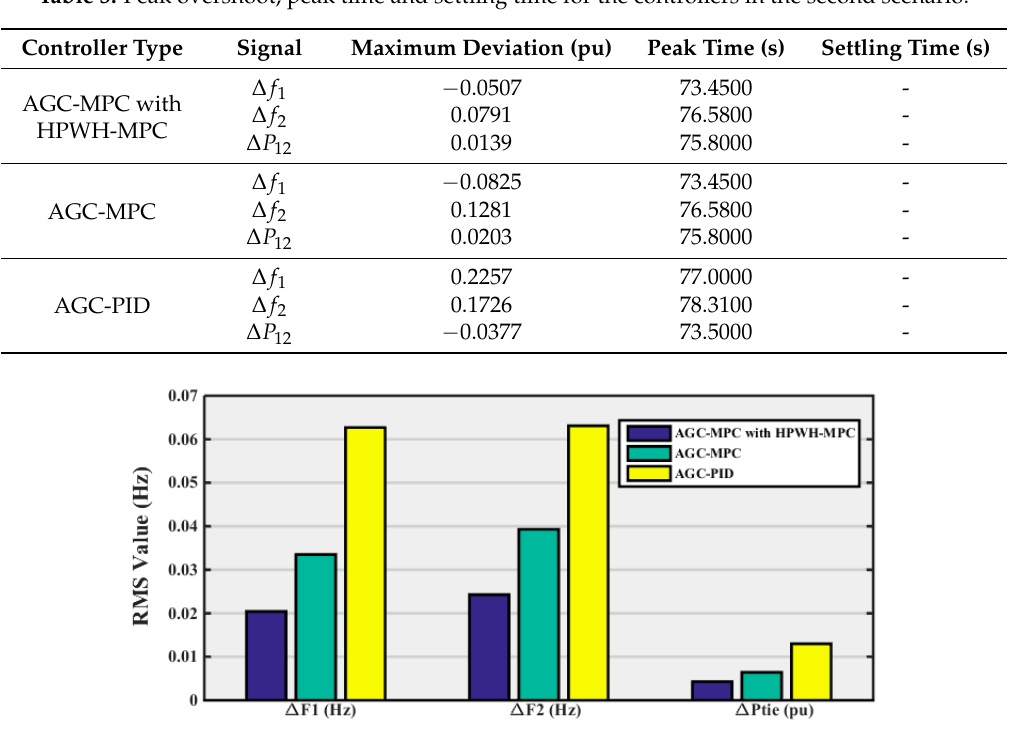
Figure 11. RMS value of deviations for Scenario 2.